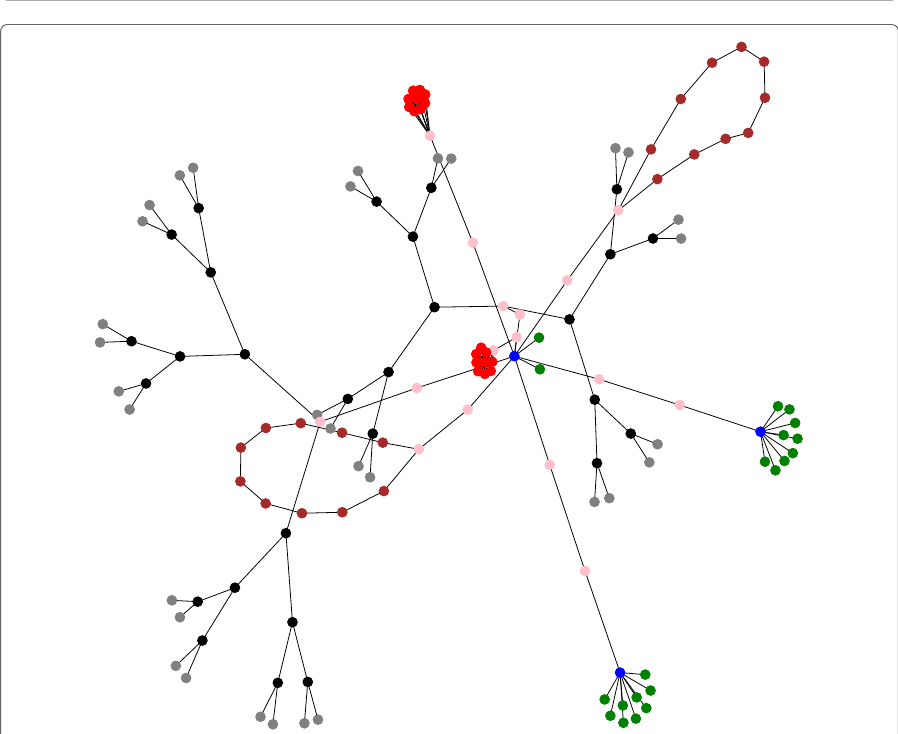
Fig. 5 Validation network. The star graph is placed at the center, and four network topologies are connected with the edge of the central star